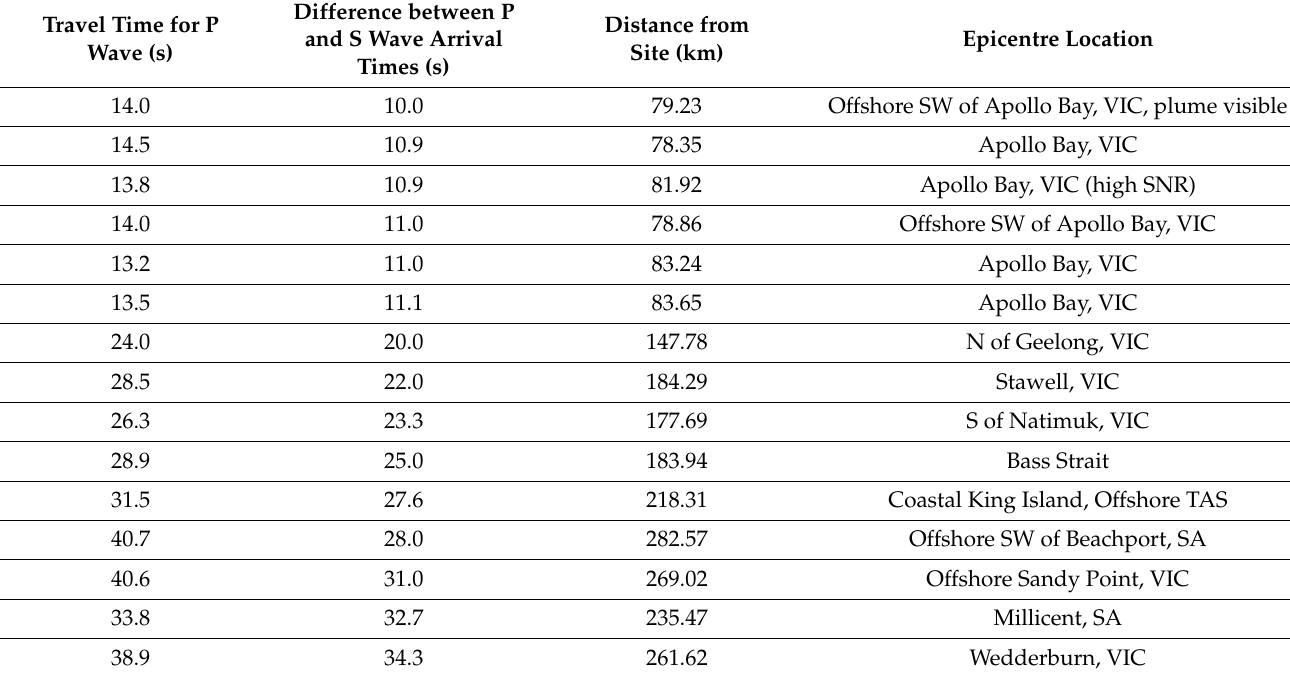
Table 1. Events used for calibration.